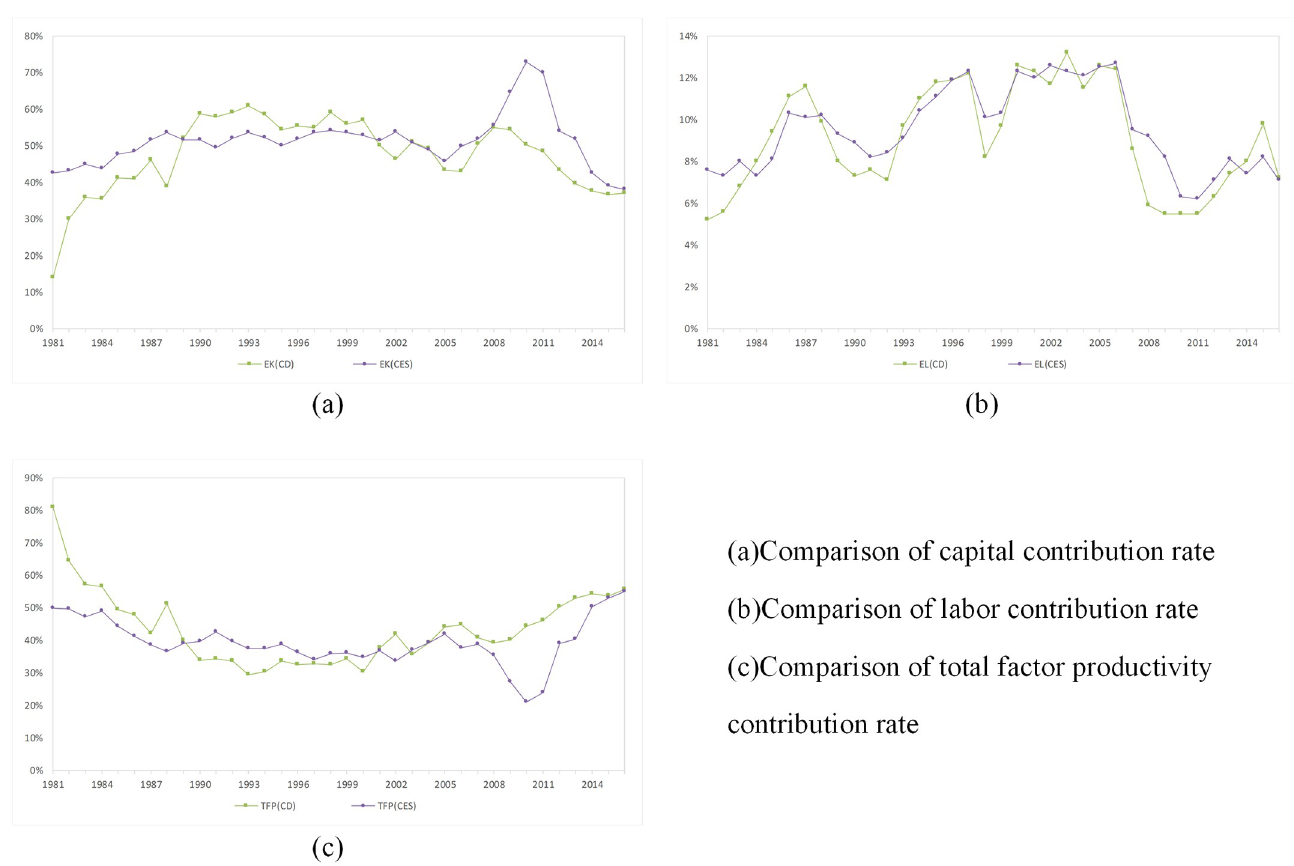
Fig 4. Comparison of the contribution rates calculated by the CES production function and the Cobb-Douglas production function.